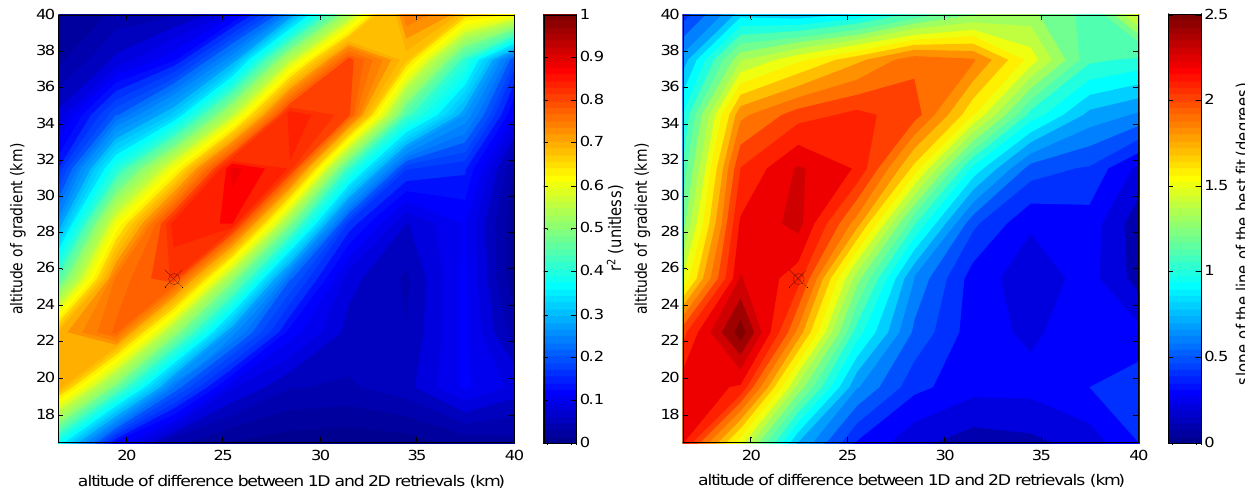
Fig. 9. Left: squared correlation coefficient ( r 2 ) between gradients (calculated by Eq. 4) occurring at different altitudes and the difference between the 1-D and 2-D retrieval. Right: same as before but now the slope of the line of the best fit is shown. Values for the example plotted in Fig. 8 are indicated with a crossed circle.